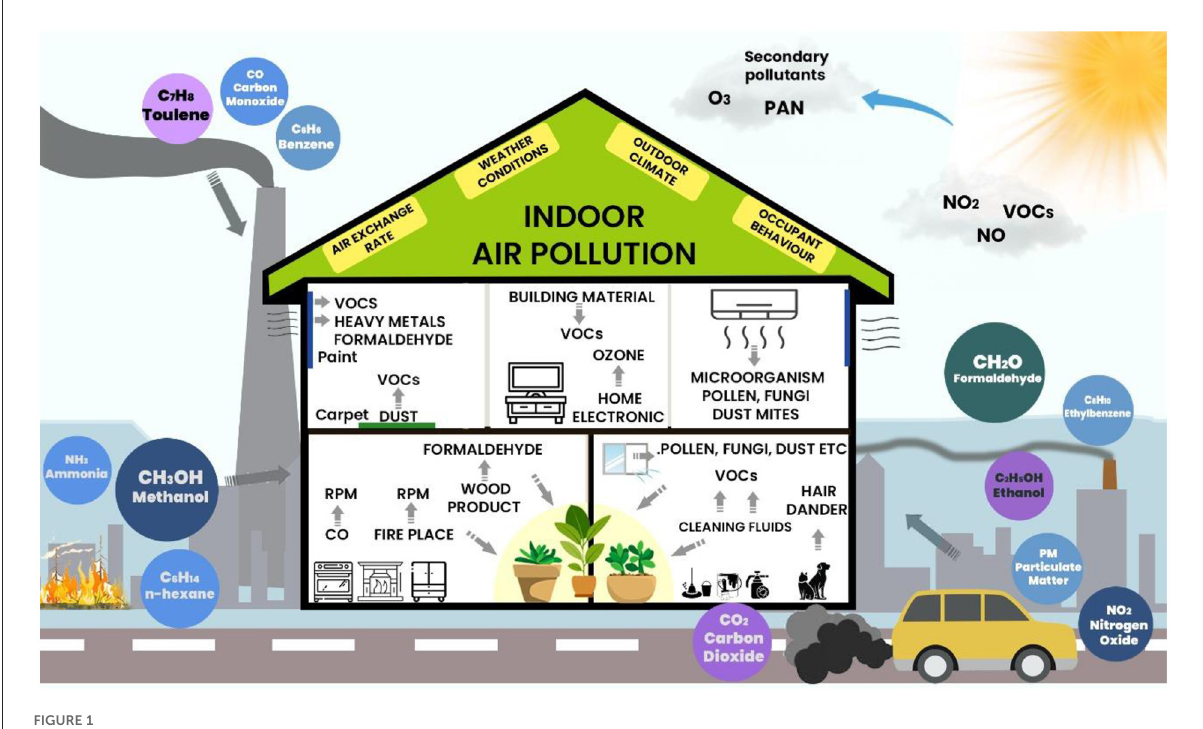
FIGURE1 Major indoor air pollutants and their